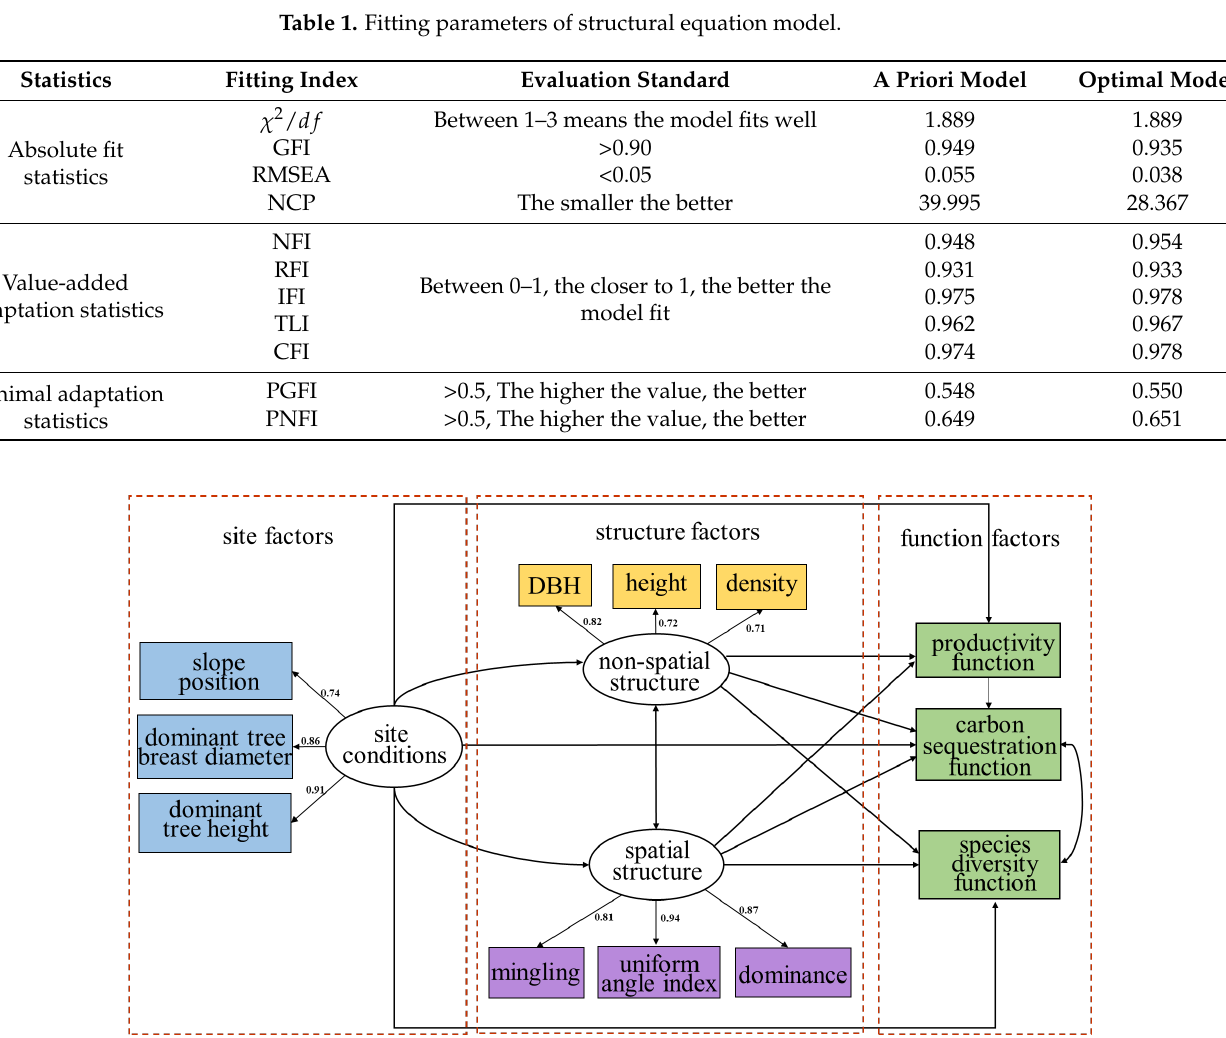
Figure 2. The optimal SEM between stand structures, site conditions and forest functions. The slope position, dominant tree breast diameter and dominant tree height are the explicit variables of site conditions. The DBH, height and density are the explicit variables of non-spatial structure. The mingling, uniform angle index and dominance are the explicit variables of spatial structure. Table 1. Fitting parameters of structural equation model.